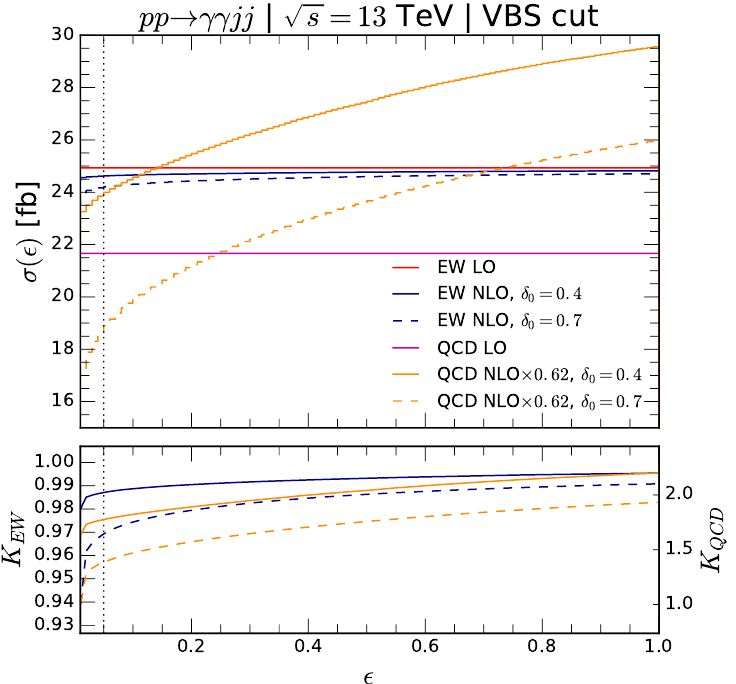
Figure 3 . Dependence on the photon-isolation parameter (cid:15) de(cid:12)ned in eq. (3.3) of the EW and QCD cross sections.